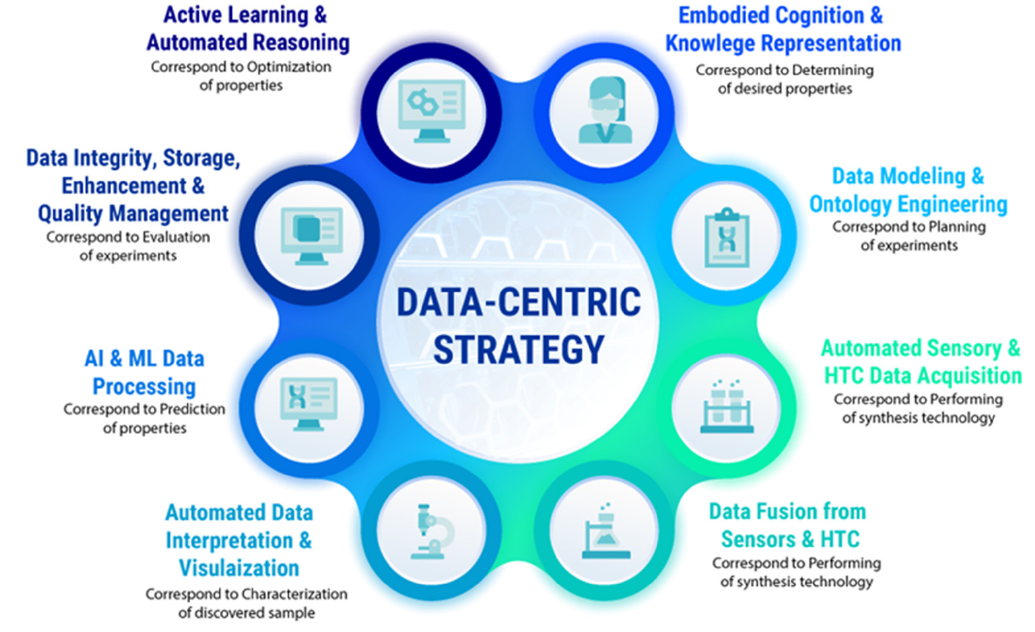
Figure 2. A data-centric research strategy for nanomaterial discovery.